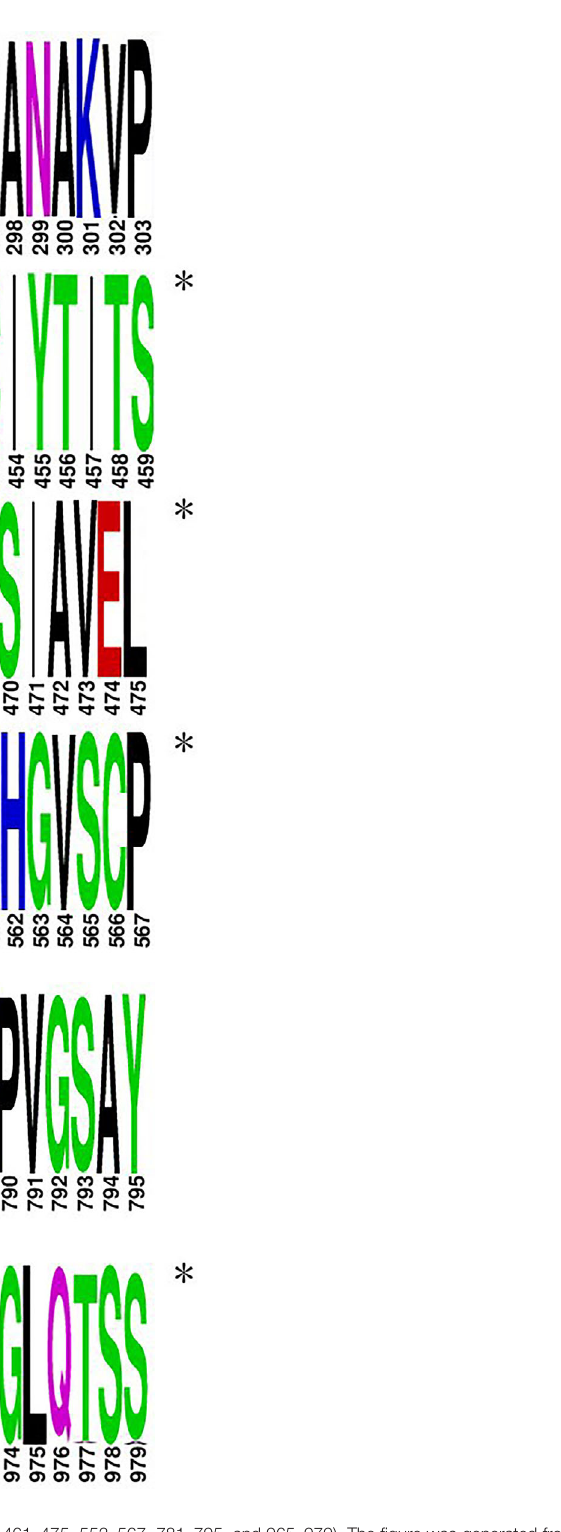
FIGURE 2 | Six epitopes selected from hotspots and clusters (a.a. 289 – 303, 445 – 459, 461 – 475, 553 – 567, 781 – 795, and 965 – 979). The fi gure was generated from the conservation analysis carried out using WEBLOGO. The height of symbols within the stack indicates the relative frequency of each a.a. at that position, with a.a.s colored according to their chemical properties as follows: polar (G, S, T, Y, C, Q, and N), green; basic (K, R, and H), blue; acidic (D and E), red; and hydrophobic (A, V, L, I, P, W, F, and M), black. Highly conserved epitopes are indicated by an asterisk